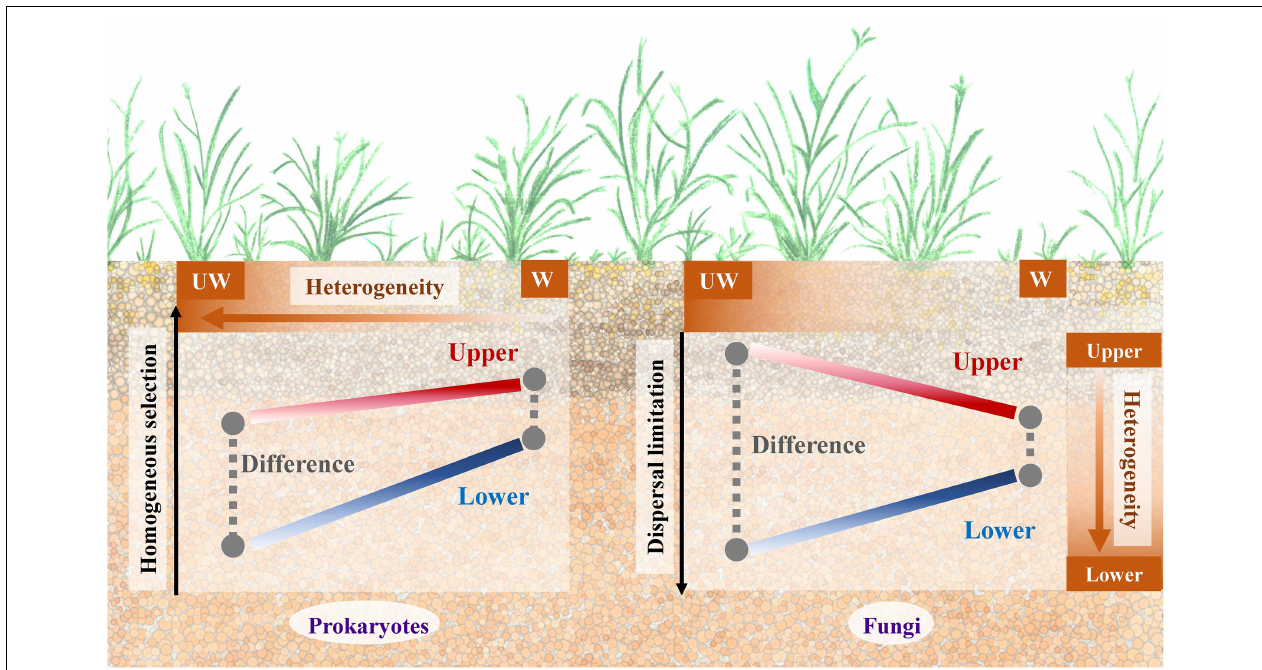
FIGURE 4 | A schematic plot to show the potential underlying mechanisms for the prokaryotic and fungal communities in alpine grassland between strata and temperature profiles. UW, unwarming; W,